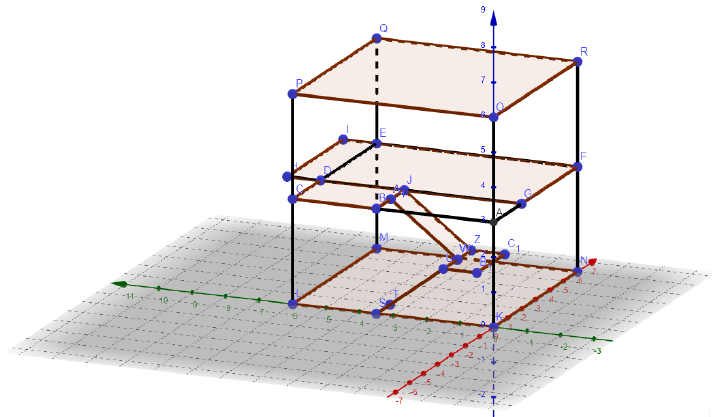
Figure 12. Digital model or geometric model of the structure of a reinforced concrete building.